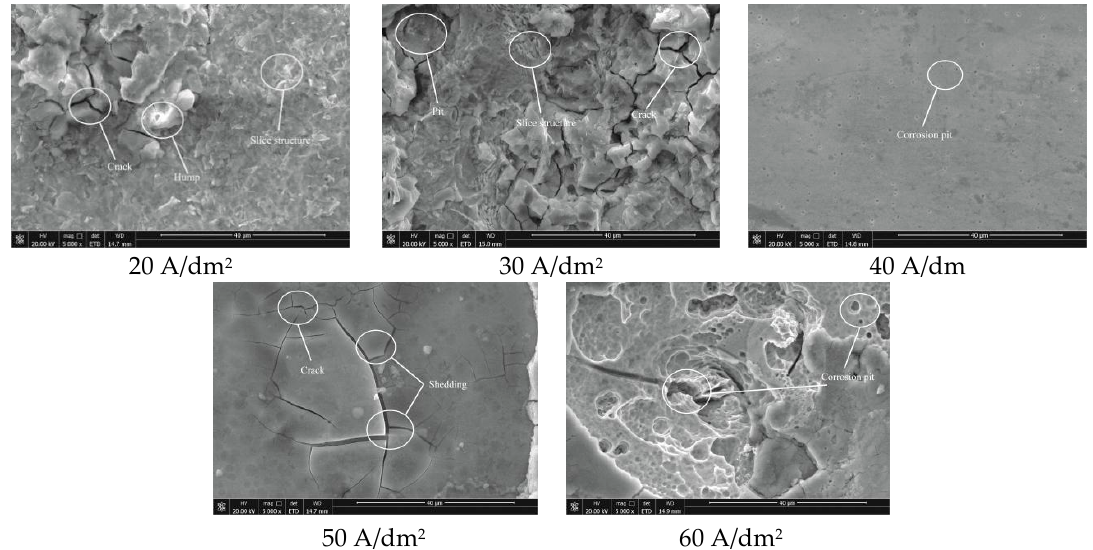
Figure 12. SEM images of surface micromorphology of Ni–P–ZrO 2 –CeO 2 coatings after